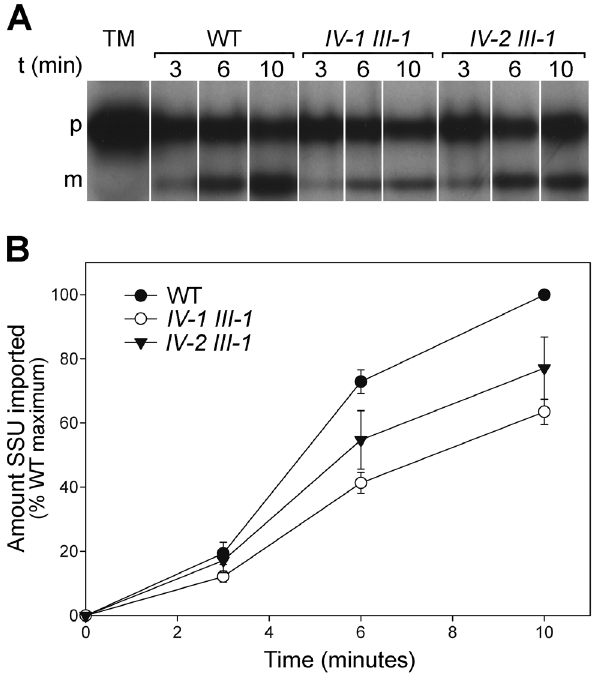
Figure 7. Analysis of chloroplast protein import efficiency in the tic22 double mutants. A. Chloroplasts were isolated from 14-day- old, in vitro -grown plants of the indicated genotypes, and used in protein import assays with [ 35 S]-methionine-labelled Rubisco SSU preprotein. Import was allowed to proceed for 3, 6 and 10 minutes, as indicated, and then samples were analysed by SDS-PAGE and fluorography. TM indicates an aliquot of the SSU translation mixture equivalent to 10% of the amount added to each assay; p and m indicate the precursor and mature forms of SSU, respectively. B. Mature protein bands observed in A were quantified using ImageQuant software, and then the data were expressed as percentages of the value for the final, wild-type time-point. These data, together with those from two additional, similar experiments, were used to calculate the mean ( 6 SD) values shown